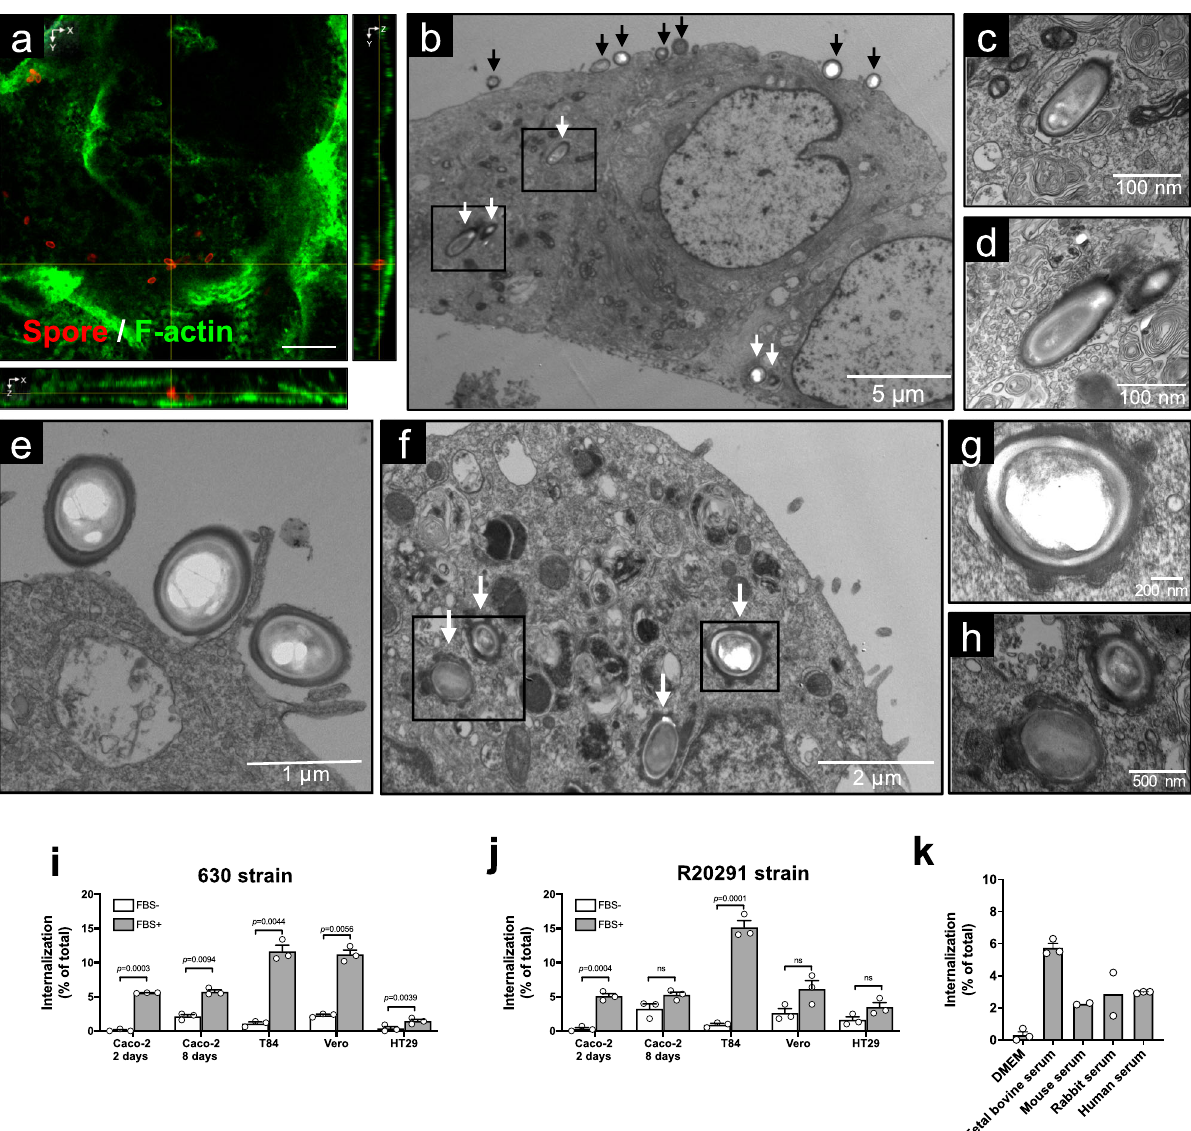
Fig. 2 C. dif fi cile spores are internalized by intestinal epithelial cells. a Representative confocal micrograph of an internalized C. dif fi cile 630 spores in T84 cells. C. dif fi cile spores are shown in red, F-actin is shown in green ( fl uorophores colors were digitally reassigned for a better representation). The images were acquired from n = 8 fi elds from two independent experiments. Yellow lines indicate an internalized spore. b – e TEM of differentiated monolayers of T84 cells infected with C. dif fi cile 630 spores. Black and white arrows denote extracellular and intracellular C. dif fi cile spores, respectively. c , d Magni fi cations of black squares of b . e An adhered C. dif fi cile spore and an apical membrane extension of T84 cells surrounding C. dif fi cile spores. f – h TEM of differentiated monolayers of Caco-2 cells infected with C. dif fi cile R20291 spores. White arrows in f indicate internalized C. dif fi cile spores. g , h Magni fi cations of black boxes in f . Micrographs are representative of n = 3 independent experiments. Internalization of C. dif fi cile spores i strain 630 and, j R20291 preincubated with FBS or culture media in undifferentiated (2 days) and differentiated (8 days) Caco-2, T84, Vero, and HT29. k Internalization of C. dif fi cile spores R20291 strain preincubated with serum of different mammalian species in Caco-2 cells. i – k Representative of n = 3 independent experiments. Error bars indicate the mean ±S.E.M. Statistical analysis was performed by two-tailed unpaired Student ’ s t test, ns, p >0.05. Scale bars a 5 μ m; c , d , 100nm; e , 1 μ m; f , 2 μ m; g , 200 nm; h ,